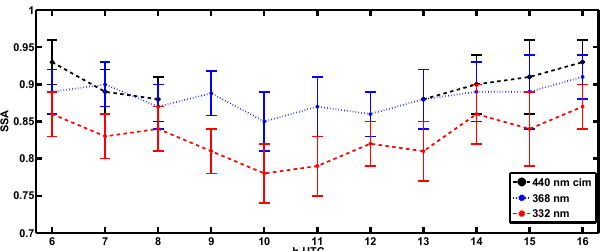
Figure 10. Diurnal patterns of SSA derived from the UVMFR and CIMEL measurements. Mean values per hour are plotted with error bars corresponding to 1 standard deviation. Local time in Athens is UTC + 2 (winter) and UTC + 3